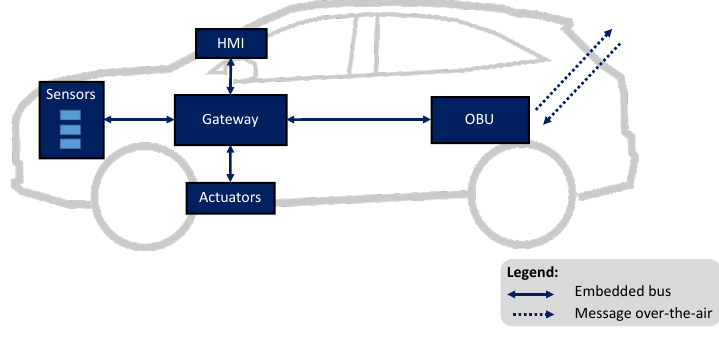
Figure 5. Overview of DS7 vehicle’s embedded